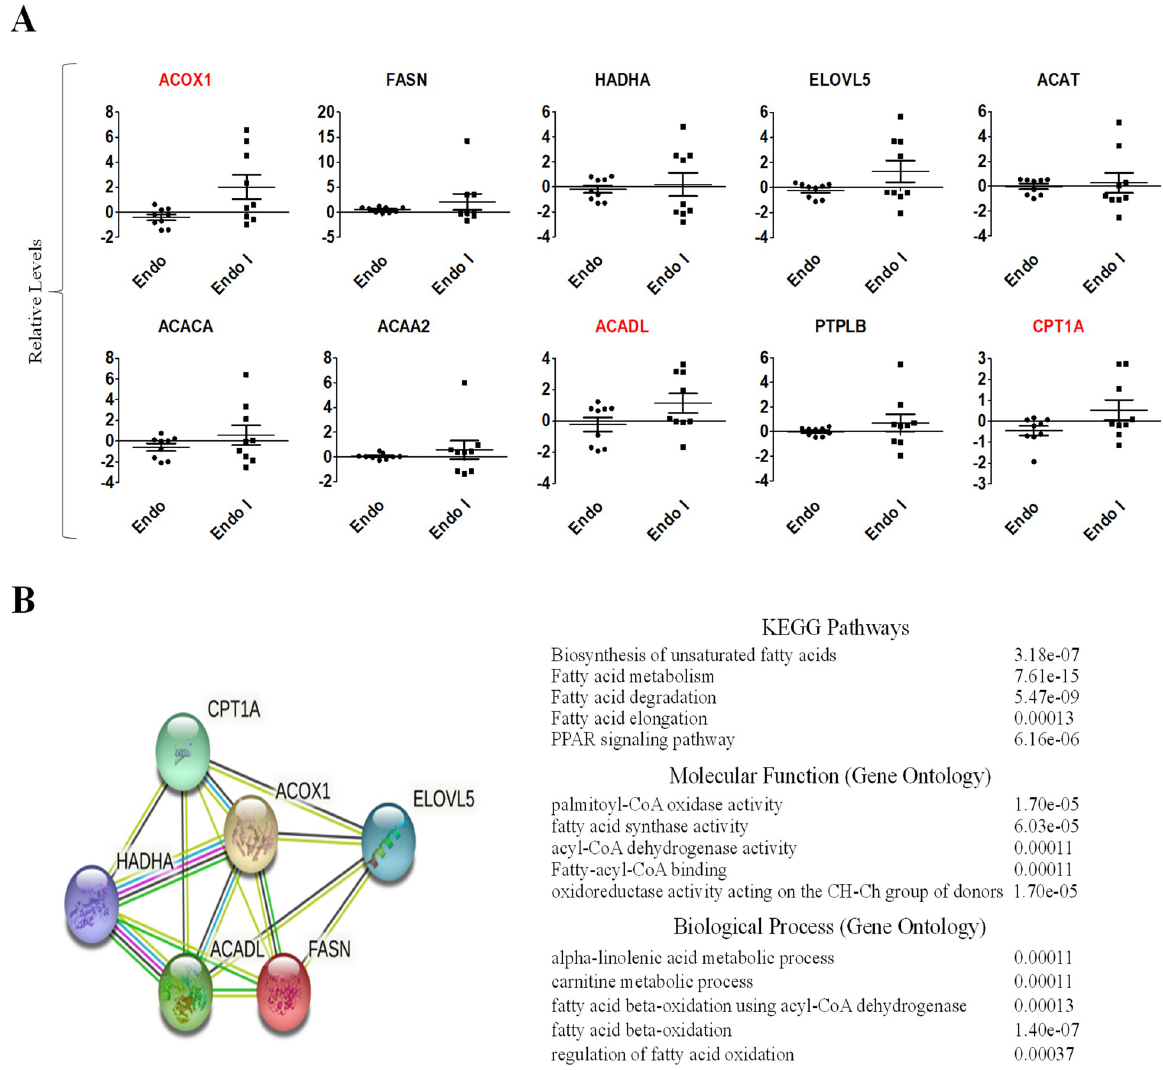
Fig 6. Expression levels of key effector genes of UCA1 as being a miRNA sponge in endometrial patients with/without infertility. (A) Expression levels of UCA1 down-stream genes involved in fatty acid metabolism pathways were analyzed by using microarray data of GEO databank (GSE120103). Endo: patients without infertility; Endo-I: patients with infertility. (B) Key pathways associated with altered down-stream effectors were analyzed by STRING protein-protein interactome databank.